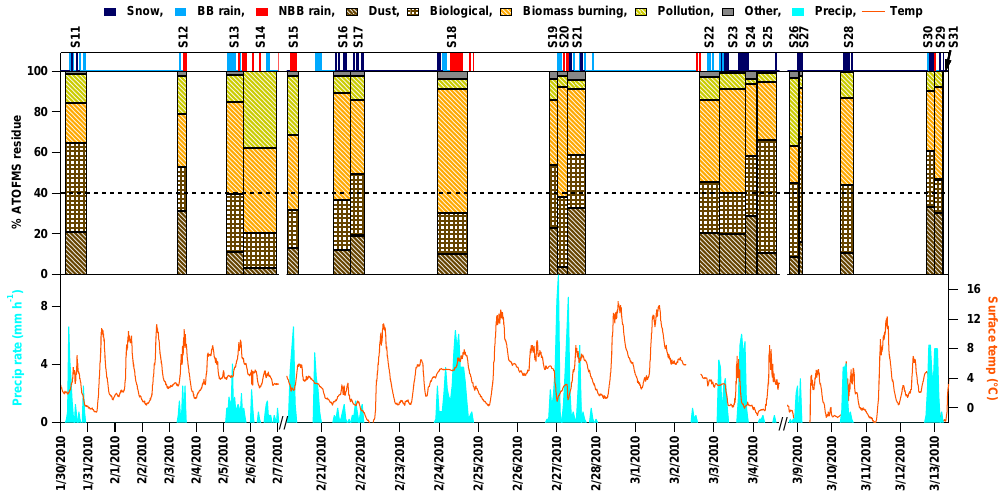
Figure 3. Precipitation process type (30min), residue type (per sample), precipitation accumulation (1h), and surface temperature (2min) during all storms from 2010. Time periods without precipitation process measurements correspond to no falling precipitation or missing S-PROF data. Each precipitation sample bar of the residue types represents one sample and the width of the bar reflects the sample collection time period. Sample IDs are provided above each sample bar and correspond to those in Table 1. Note that the sample length is only shown during rain or snow and thus may not directly correspond to times provided in Table 1. The horizontal black dashed line represents the 40% mark for ATOFMS.